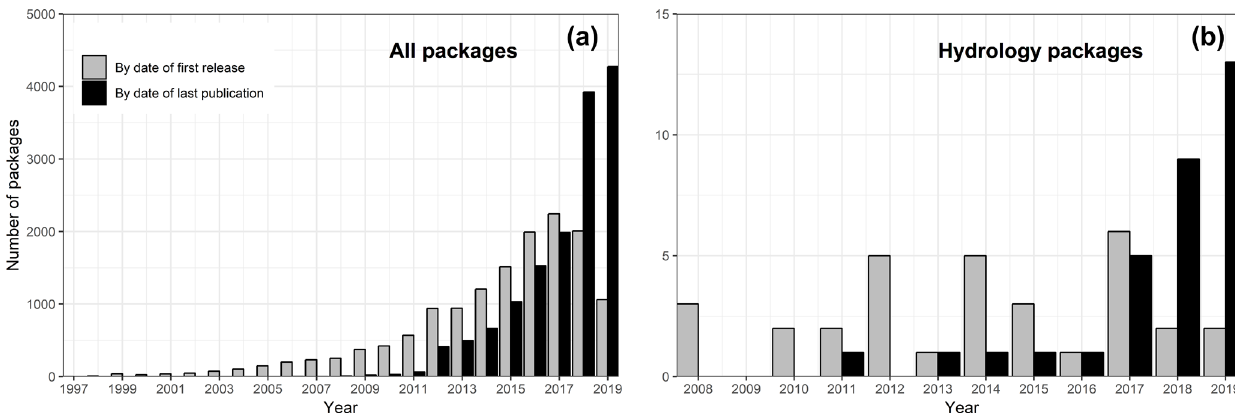
Figure 1. The number of R packages available on CRAN (1997–2019). All packages are shown in (a) , and hydrology packages only (defined as those that include the string “hydro” within the package metadata; erroneous packages containing terms like hydrocarbon were removed) are shown in (b) . Bar colours indicate number of packages published based on (1) date of first release (grey bars; https://cran.r-project.org/ src/contrib/Archive/) and (2) date of last publication – i.e. most recent publication date of packages that are currently available on CRAN (black bars; https://cran.r-project.org/web/packages/available_packages_by_date.html). In both cases each package is counted only once; for example the package hydroTSM was first released in 2010 (grey), but its most recent update was in 2017 (black). The script to produce this figure is provided in the Supplement. Data were downloaded from CRAN on 23 June 2019; thus the year 2019 is